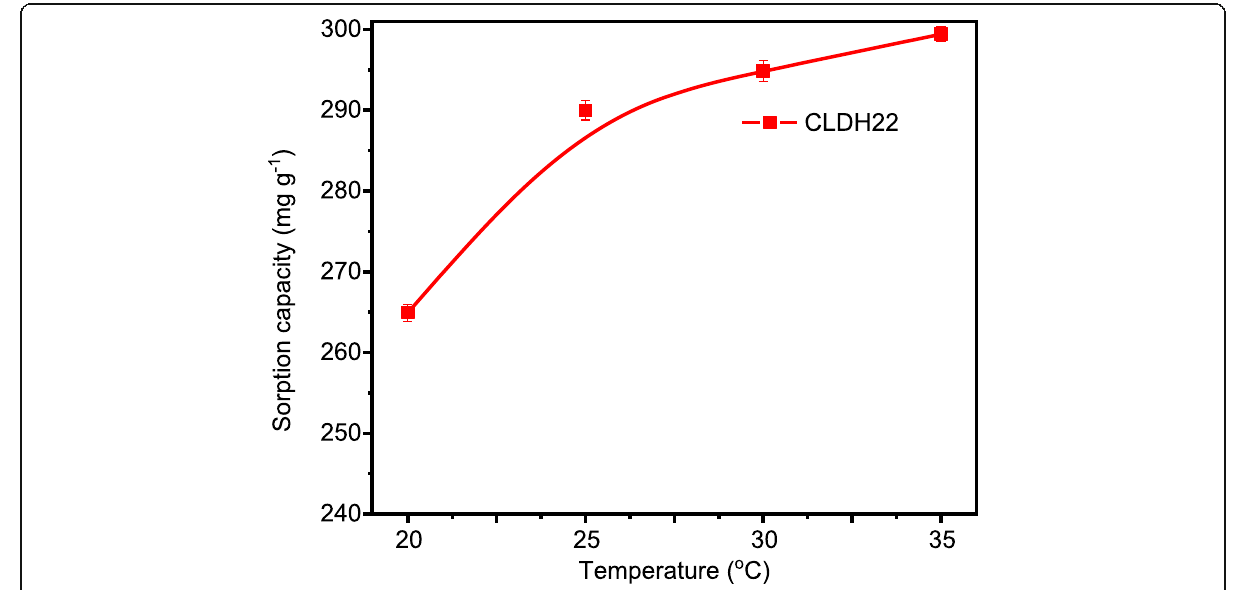
Fig. 8 Effect of temperature on adsorption capacity of IDB onto CLDH22 adsorbent, C i = 300 mg L − 1